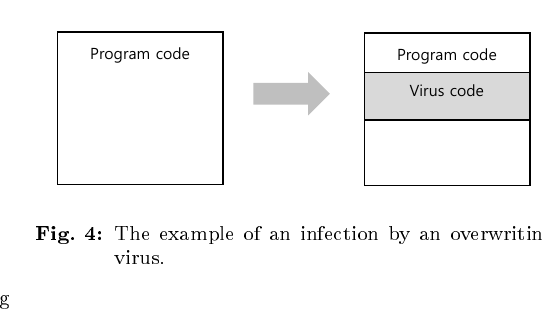
Fig. 5. Structure of PE format.